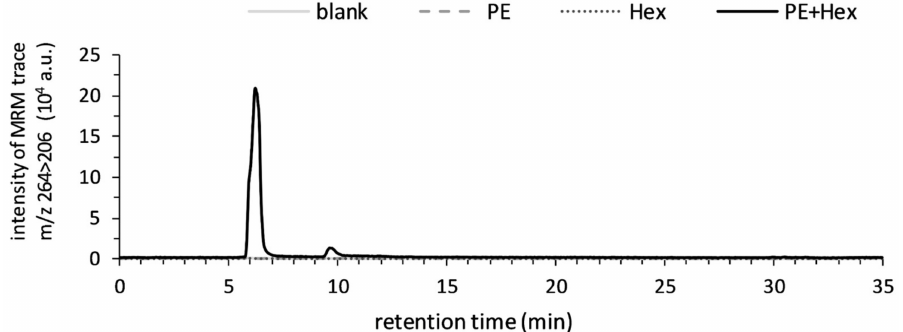
Figure 2. Formation of 2-pentyl-3,5-dibutyl-dihydropyridine in the presence of both, PE (16:0 / 18:1) (0.8 mM) and hexanal (1.6 mM). Overlaid chromatograms (MRM: m / z 264 > 206) recorded with